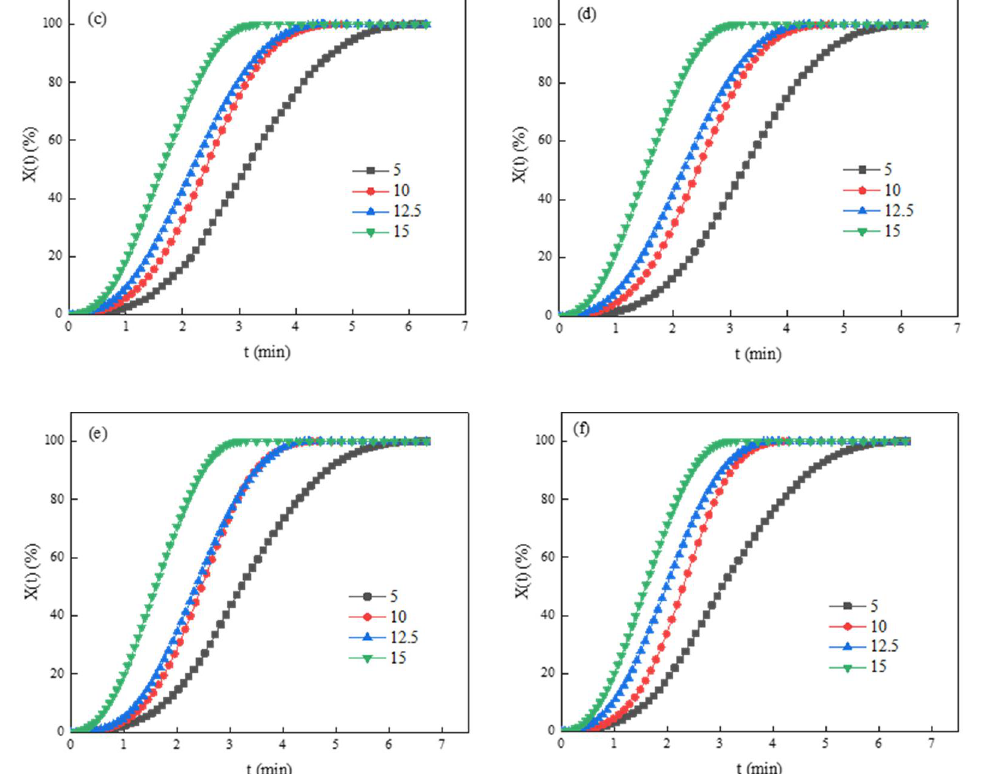
Figure 3. X(t)-t curves of PET. ( a ) PET; ( b ) PSLDH 0.01 wt%; ( c ) PSLDH 0.03 wt%; ( d ) PSLDH 0.05 wt%; ( e ) PSLDH 0.07 wt%; ( f ) PSLDH 0.1 wt%.